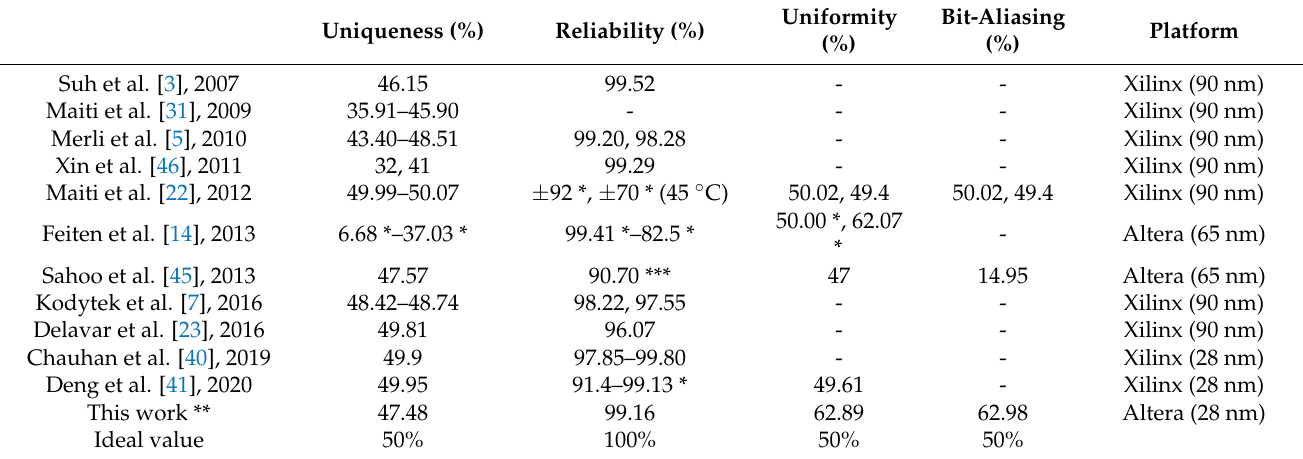
Table 6. A comparison of the metrics of the proposed RO-PUF with the metrics of others. Uniqueness (%) Reliability (%)